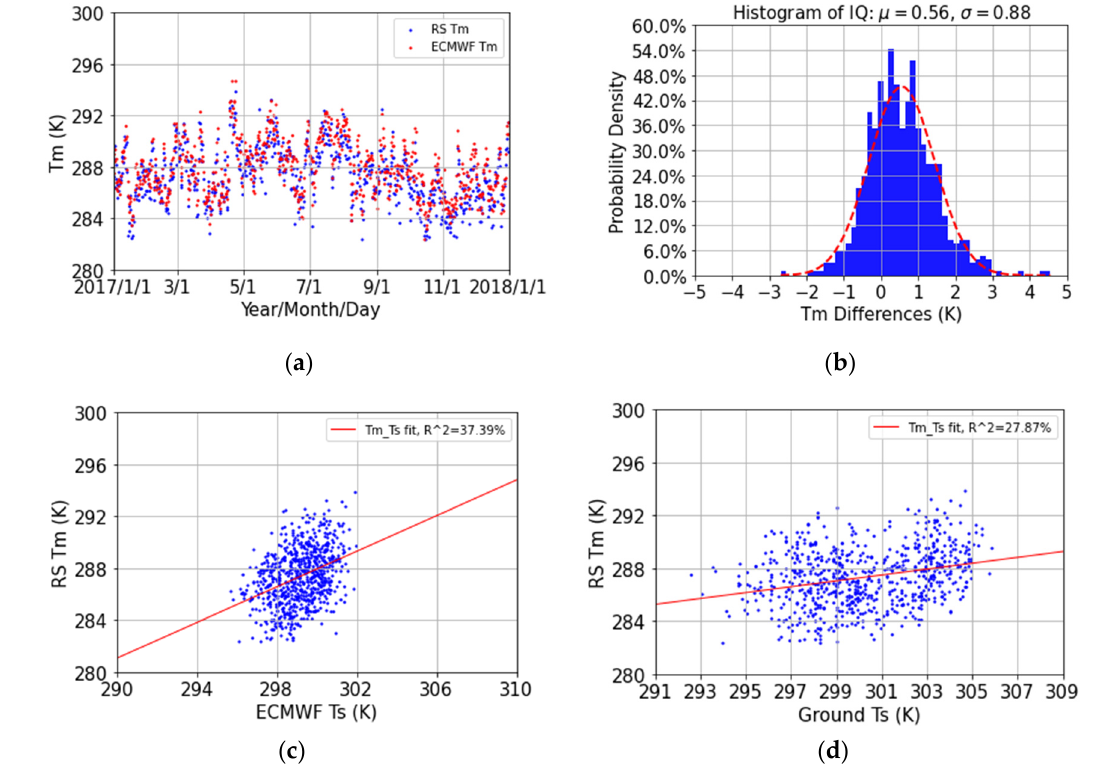
Figure 4. ( a ) FAA1 station: comparison between the RS −𝑇 (cid:3040) values computed from Equation (14) (blue dots) and the VMF1/ECMWF − 𝑇 (cid:3040) values (red dots), and ( b ) histogram of the differences between the RS −𝑇 (cid:3040) values and the VMF1/ECMWF −𝑇 (cid:3040) values, and ( c ) linear fit between the RS −𝑇 (cid:3040) and the VMF1/ECMWF −𝑇 (cid:3046) , and ( d ) linear fit between the RS −𝑇 (cid:3040) and the surface temperature measurements, 𝑇 (cid:3046) , from the FAA1 ground weather station.